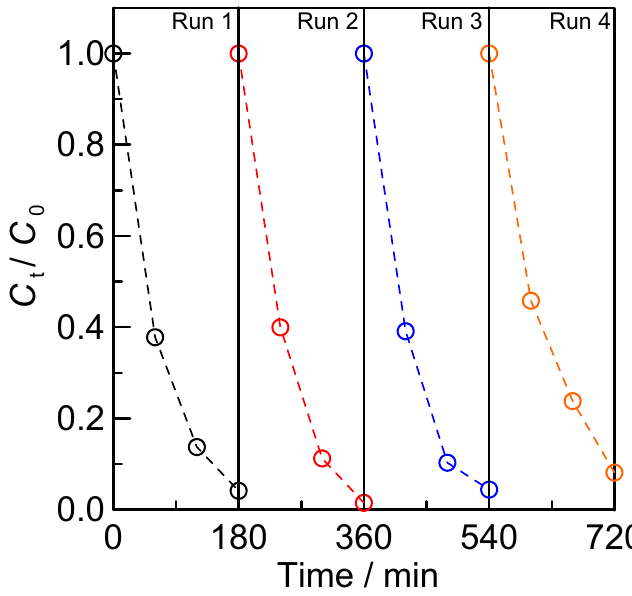
Figure 11. Time course of specific concentration C t / C 0 of methylene blue under blue LED illumination for silver phosphate coated substrate (calcined at 500 °C) during the recycling test. Here, C 0 is the initial concentration of methylene blue and C t is the concentration at time t